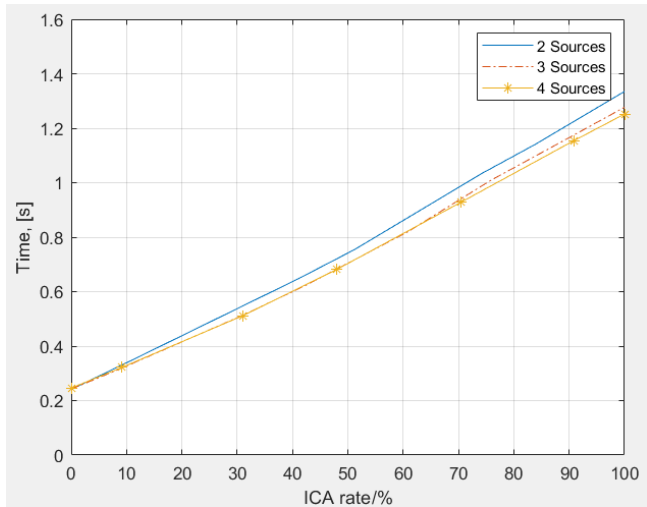
ff erent number of sound